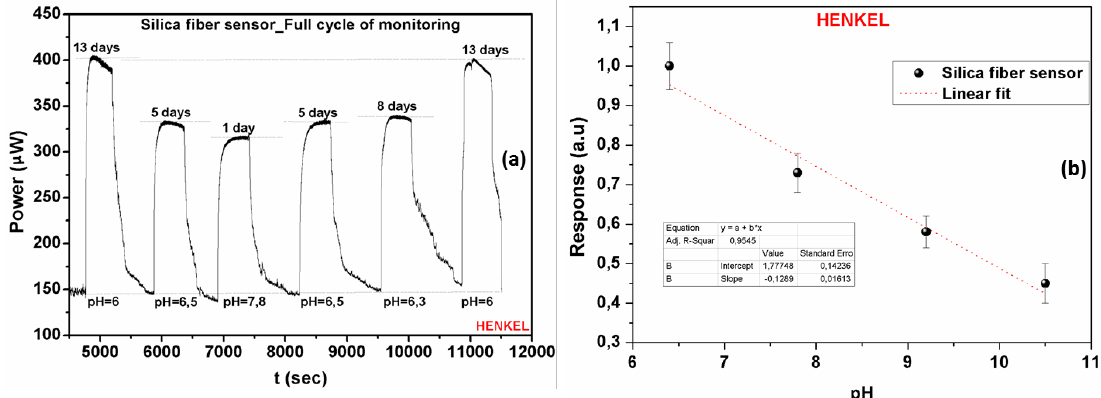
Figure 11. ( a ) Experimental evaluation of the silica optical fiber-based sensors’ response and its exhibited reversibility during monitoring of the Henkel coolant ageing process. The fast time response to the coolants’ presence is also demonstrated. ( b ) Normalized electrical response of the silica optical fiber sensor as a function of the pH index in the Henkel coolant fluid, for the entire pH range of coolant operation.